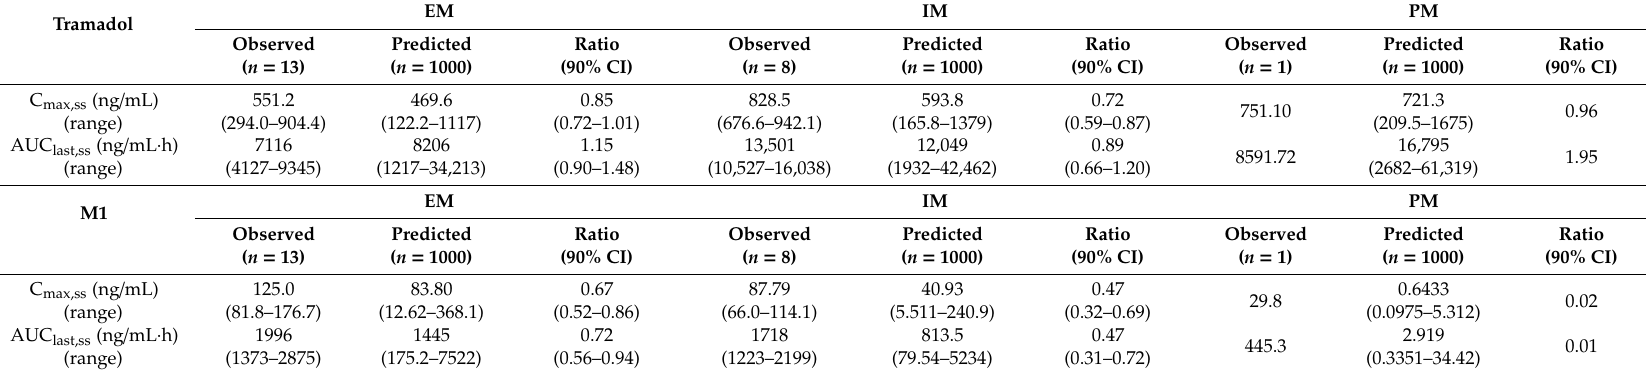
Table 7. Predicted and observed geometric mean PK parameters for tramadol and M1 according to CYP2D6 genotype following oral administration of 100 mg tramadol ER tablet twice daily (total five